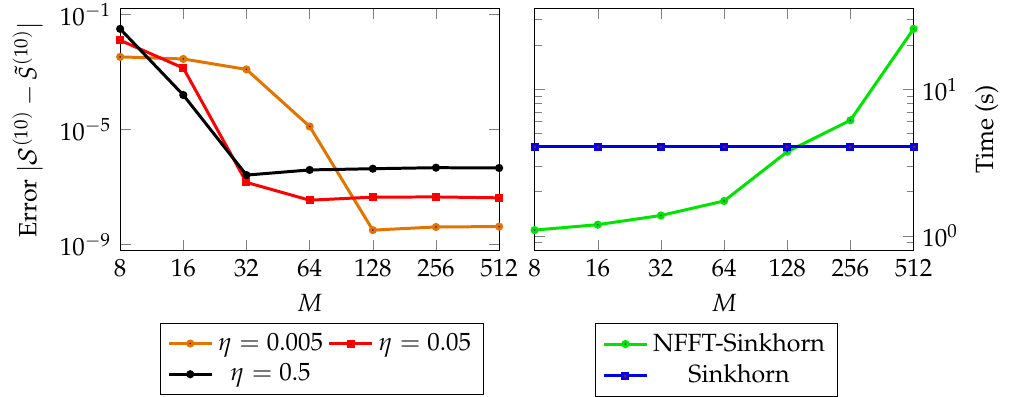
Figure 5. MOT η with circle-structured cost function, where d = 2, K = 3, N = 1000, and p = 3. Left: Approximation error of S ( 10 ) between Sinkhorn and NFFT-Sinkhorn algorithm depending on the number of Fourier coefficients M . Right: Computation time in